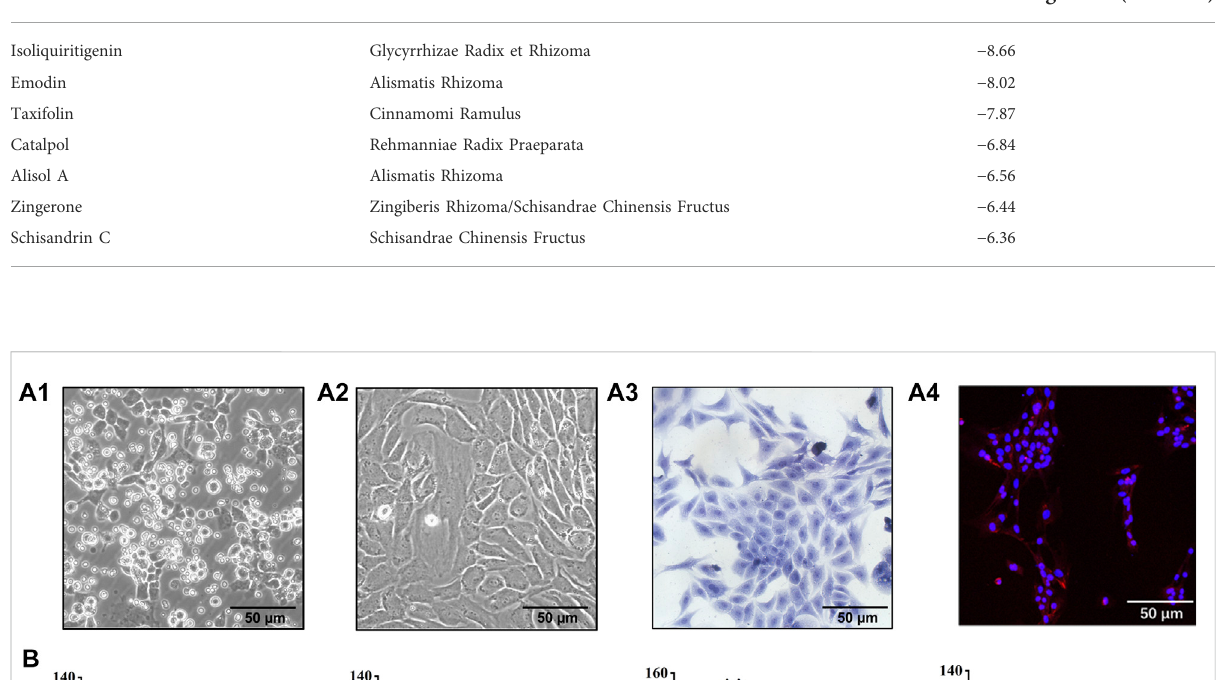
explore the effect of above seven potential active constituents on PPAR γ expression, we used protein capillary electrophoresis to test the expression of PPAR γ in chondrocytes after treatment